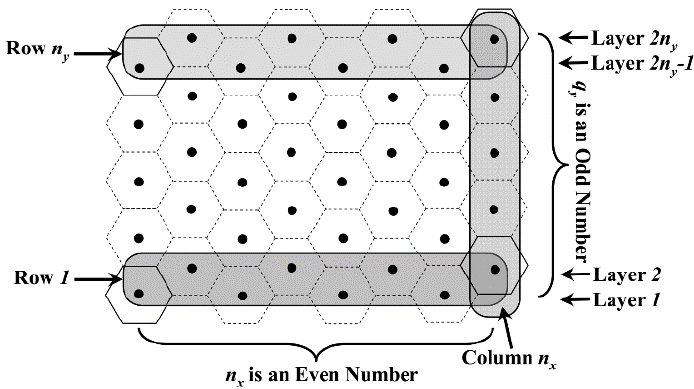
Figure 10. Distribution of VTPs when q y is even and n x is odd.